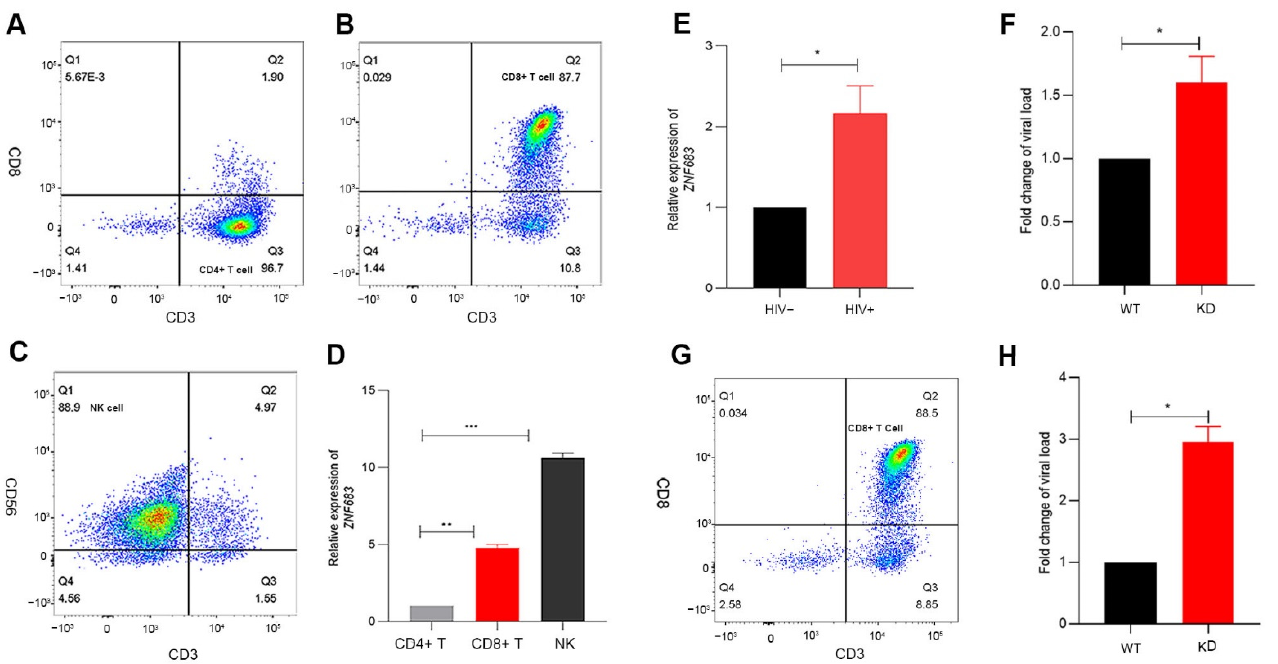
Figure 6. Analysis of the role of ZNF683 in HIV infection. ( A ) Isolation of CD4+ T, ( B ) CD8+ T and ( C ) NK cells from healthy human PBMCs and ( D ) expression of ZNF683 in different human immune cells. ( E ) Expression of ZNF683 in HIV patients. ( F ) ZNF683 inhibited HIV infection in vitro. ( G ) Isolation of CD8+ T cells and ( H ) ZNF683+ CD8+ T cells inhibited HIV infection in vitro. The bars and error bars indicate the means ± SEMs. Paired t tests were used to compare groups. * p < 0.05, ** p < 0.01, *** p < 0.001